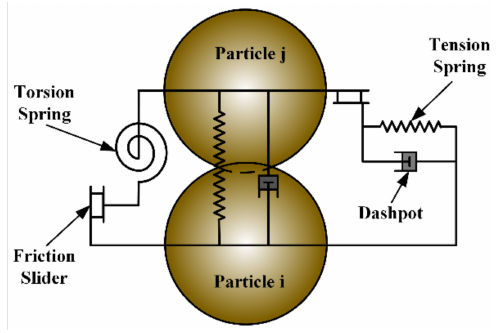
Figure 2. Hertz–Mindlin mechanical